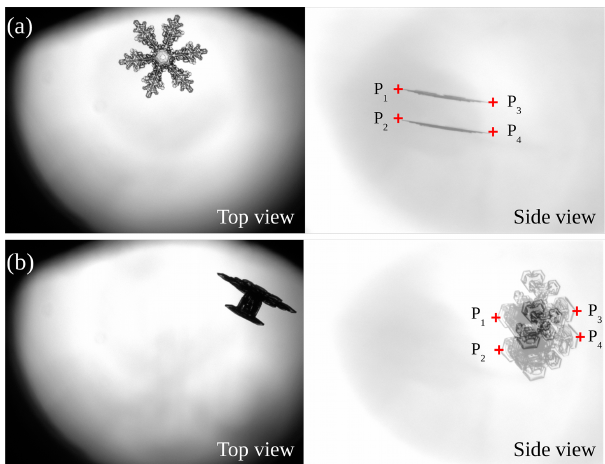
Figure 1. Two particle examples (a–b) . Left: top-view images. Right: side-view images, which are exposed twice to enable fall speed measurements. Both viewing geometries are used to classify the particle shape. In both examples, two pairs of points ( P 1 , P 3 and P 2 , P 4 ) were selected to determine the fall